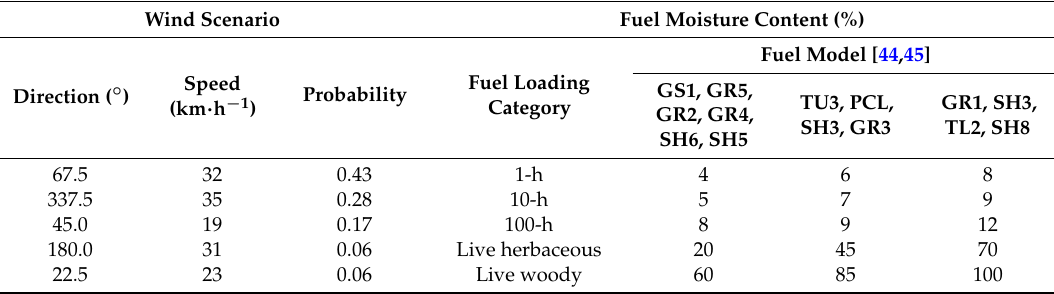
Figure 3. Land cover map (idena.navarra.es) and assigned fuel models [44,45] for the wildfire modeling. The large urban development areas in the southeast correspond to the capital city of Pamplona. Cereal crops occupy all the flat cultivated areas to the south and mountains in the northern part are covered by mosaics of different forest types. See fuel model parameter details in the references [44,45]. Table 2. Fire weather input data, corresponding to the historical 97th percentile conditions, used for wildfire simulations. We considered the most frequent wind directions (frequency >5%) during the last 17 wildfire seasons. Historical weather data were gathered from the meteorological station of Pamplona (meteo.navarra.es). We used standard fuel models for fire modeling, see references [44,45] for further details .